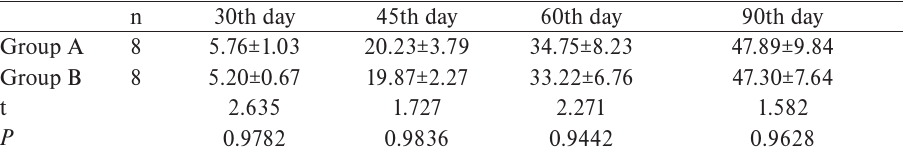
Table 2. Numbers of microvessels at each time